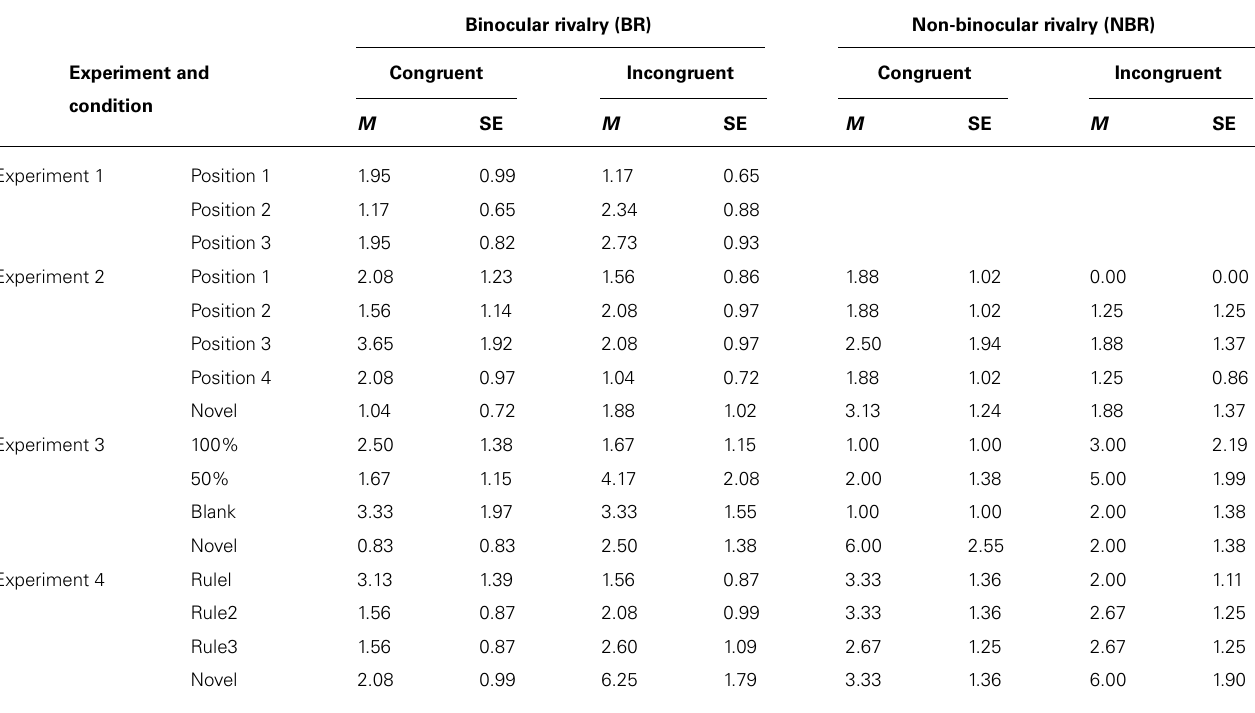
Table 1 | Percentage of error rates in all